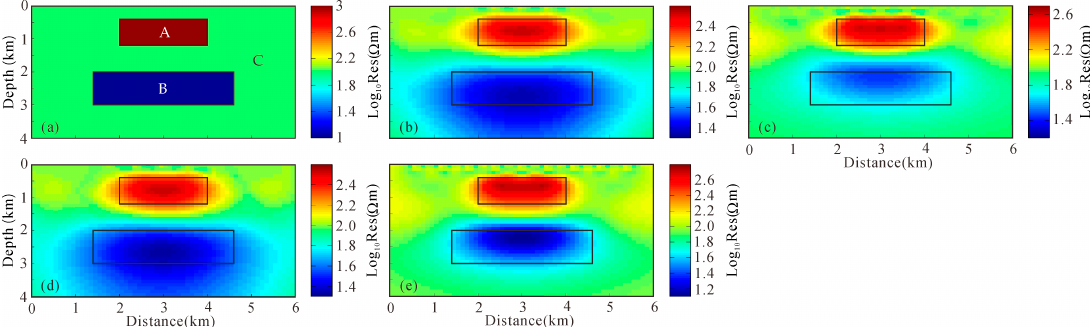
Figure 4. The MT inversion results obtained using separate and joint inversion. ( a ) Resistivity true model; ( b ) Resistivity separate inversion model using L2 regularization; ( c ) Resistivity separate inversion model using elastic-net regularization; ( d ) Resistivity joint inversion model using L2 regularization; ( e ) Resistivity joint inversion model using elastic-net regularization. The black box indicates the boundary of the anomalous body.